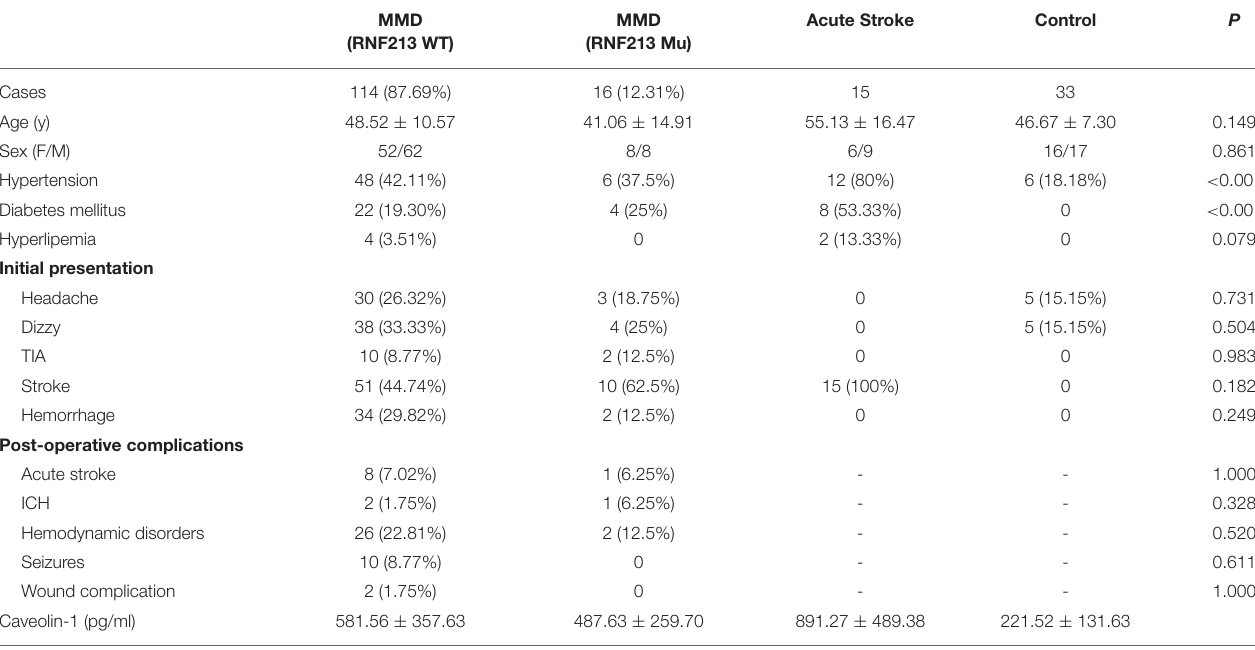
TABLE 1 | The clinical properties of patients from healthy controls (CNT), MMD groups, and acute stroke